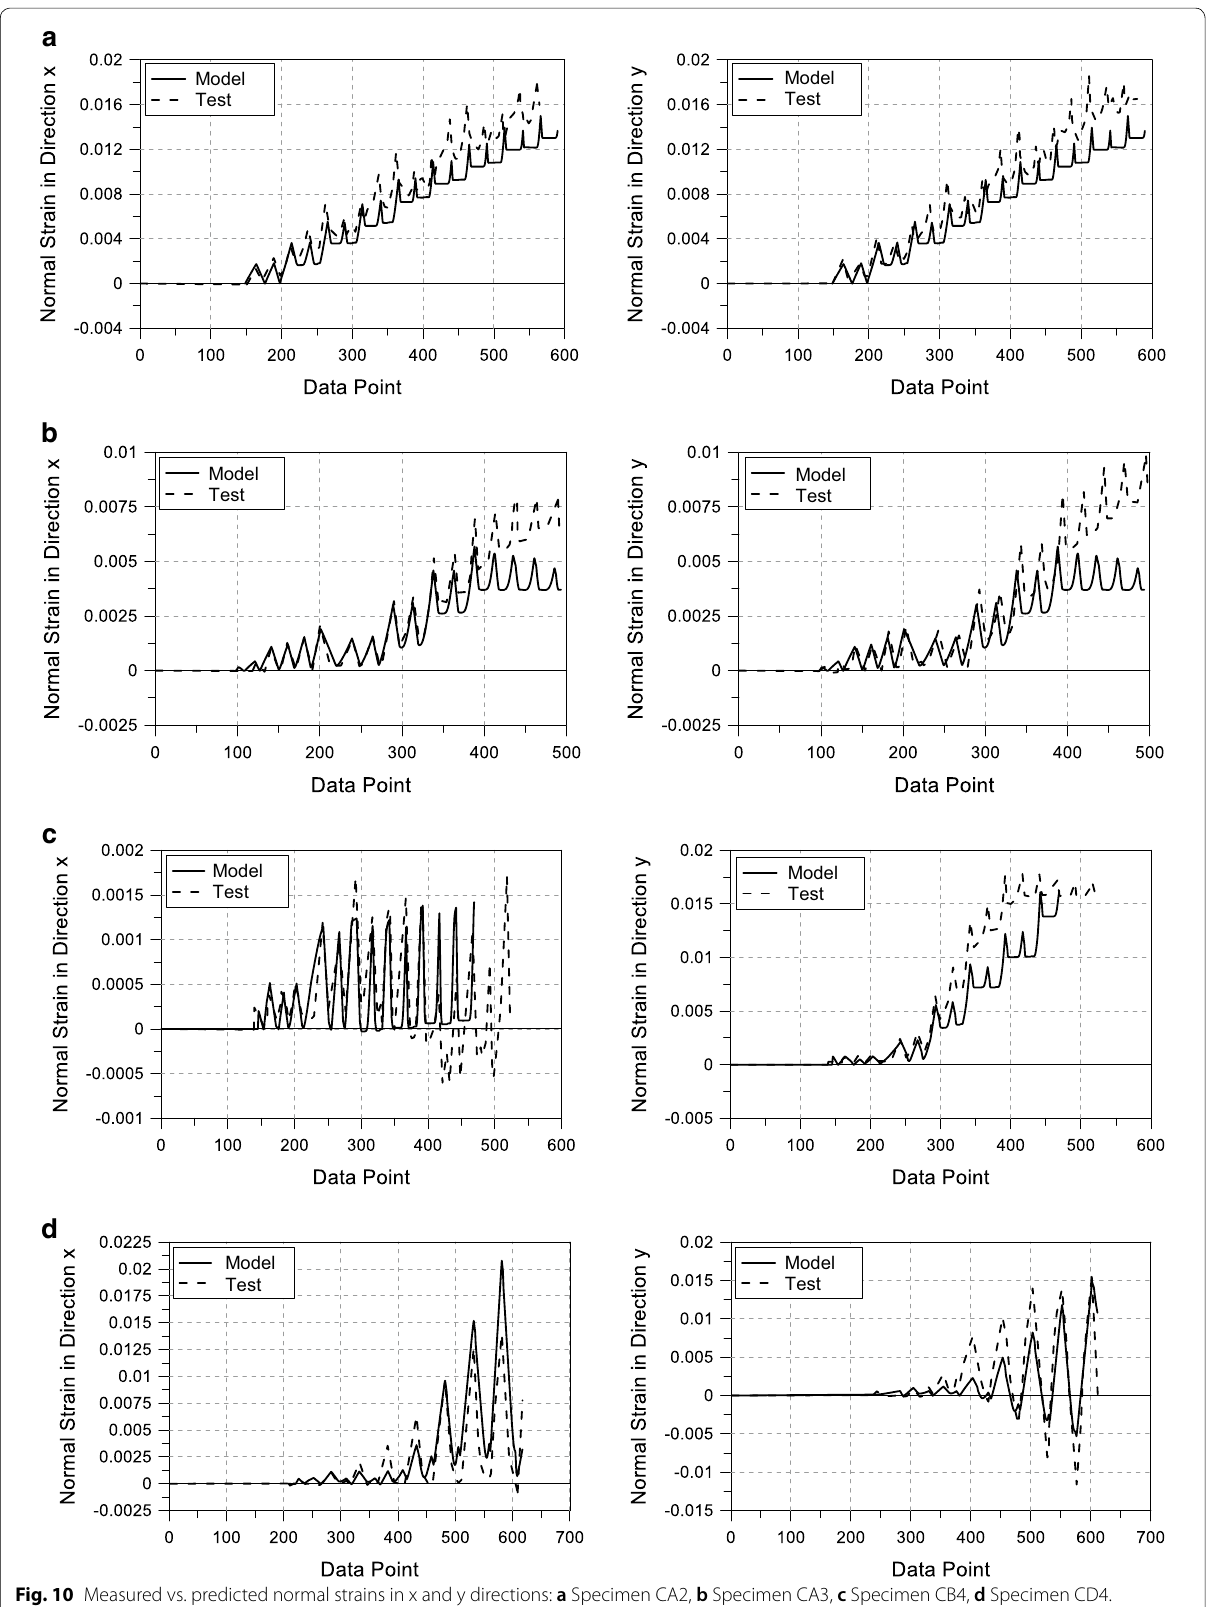
Fig. 10 Measured vs. predicted normal strains in x and y directions: a Specimen CA2, b Specimen CA3, c Specimen CB4, d Specimen